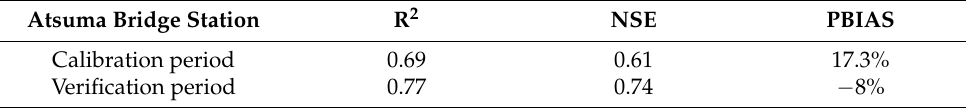
Figure 6. The comparison of observation discharge and calculation discharge at Atsuma Bridge station from 2015 to 2019 (note: observation discharge data is missing from 20 July to 30 September 2017, not included). Table 3. Error analysis of SWAT in runoff simulation.